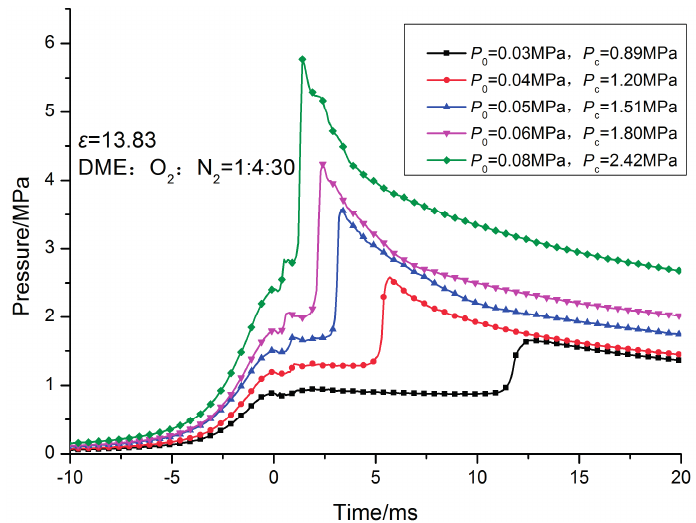
Figure 17. Effect of initial pressure on two-stage ignition delay ( ε = 13.83).